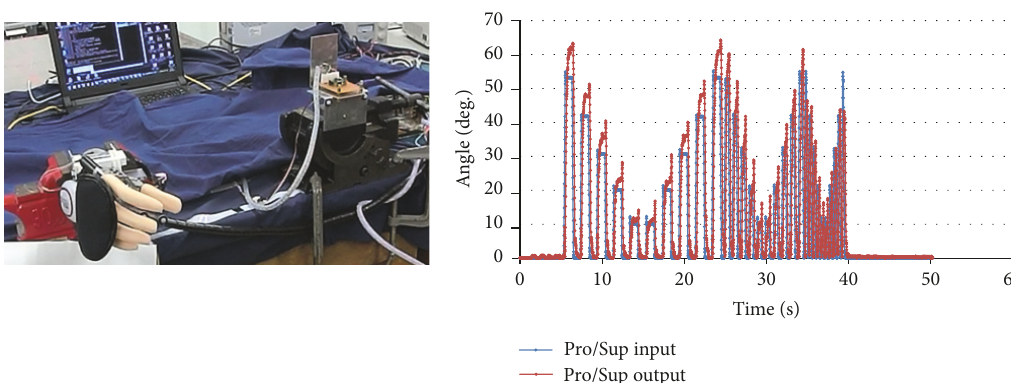
Figure 12: Results and experiment environment of supination/pronation